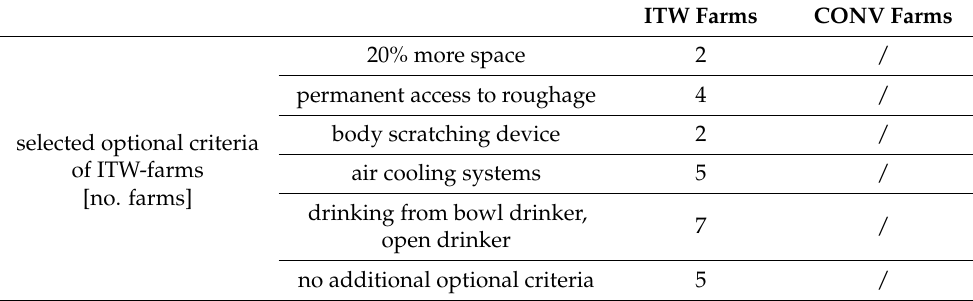
Table 4. Cont. ITW Farms CONV Farms 20% more space 2 / permanent access to roughage 4 / body scratching device 2 / selected optional criteria of ITW-farms air cooling systems 5 / [no. farms] drinking from bowl drinker, 7 / open drinker no additional optional criteria